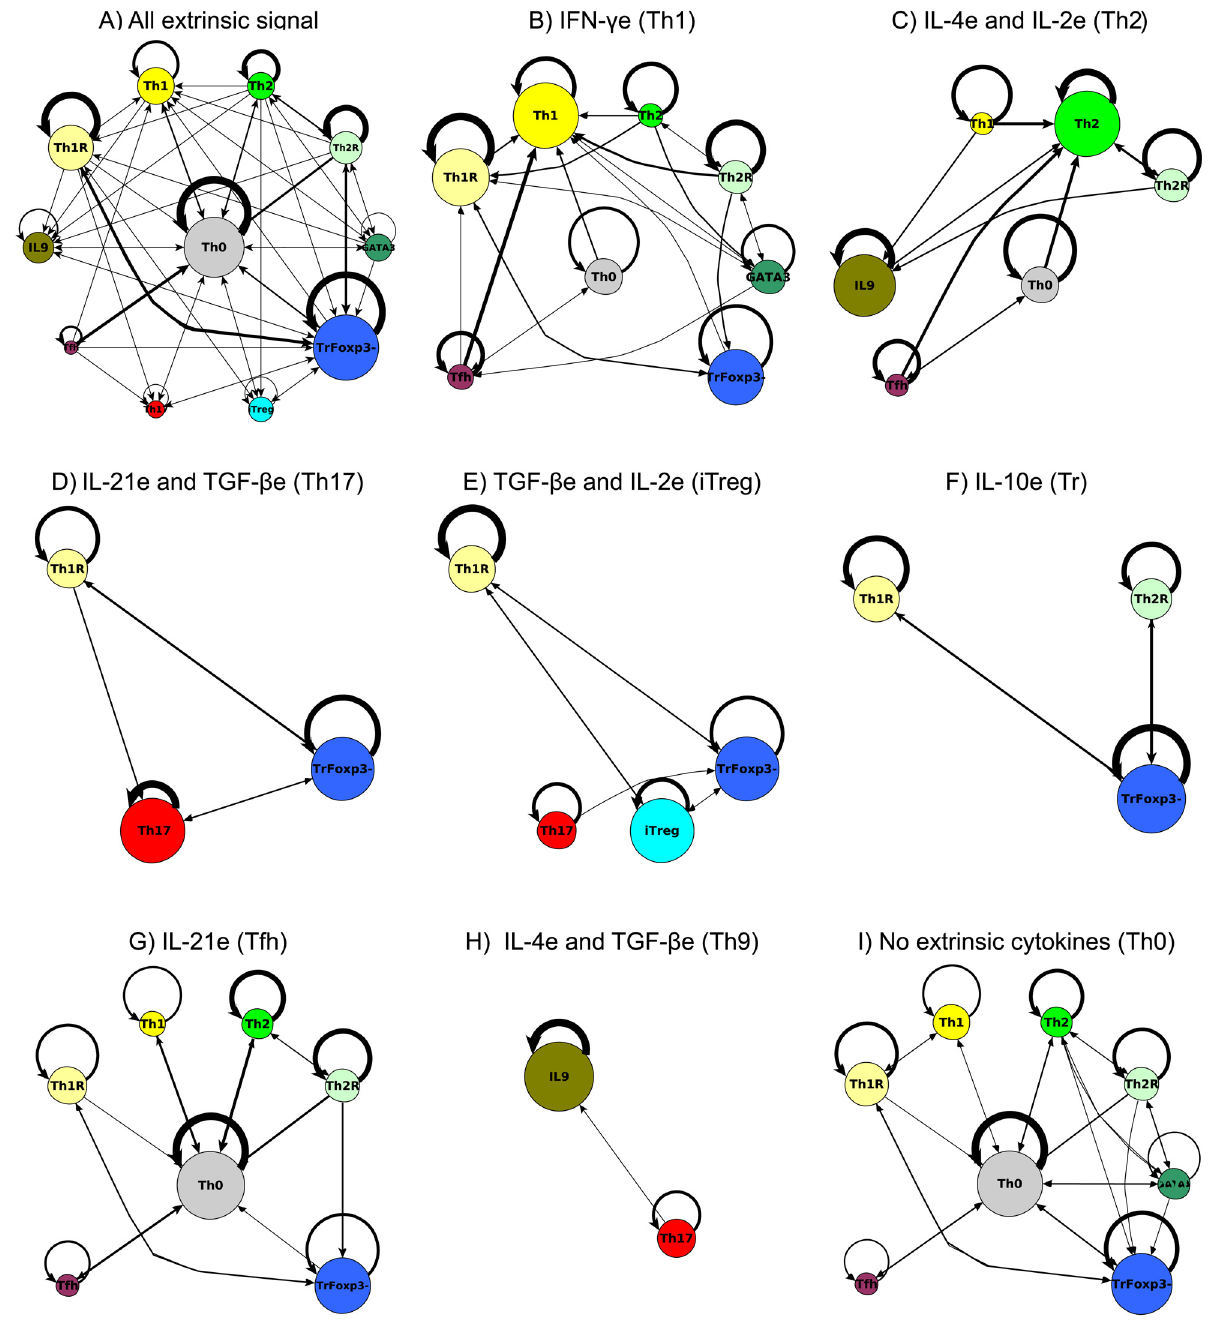
Fig 5. Cell fate map in response to the micro-environment and perturbations of the TSRN model. The values of the extrinsic signals of the TSRN were fixed according to different polarizing micro-environments, and the resulting attractors were transiently perturbed. The nodes represent CD4+ T cell types, and the node sizes correspond to the size of the basin of attraction. The edges represent transitions between cell types, the width of the edges corresponds to the number of times the transition occurred in logarithmic scale, and self-loops correspond to perturbations where the network returned to the original cell type. The following micro-environments were studied: combinations of: (A) all extrinsic cytokines, (B) IFN- γ e (Th1), (C) IL-4e and IL-2e (Th2), (D) IL-21e and TGF- β e (Th17), (E) TGF- β e and IL-2e (iTreg), (F) IL-10e (IL10), (G) IL-21e (Tfh), (H) IL-4e and TGF- β e (Th9), (I) no extrinsic cytokines